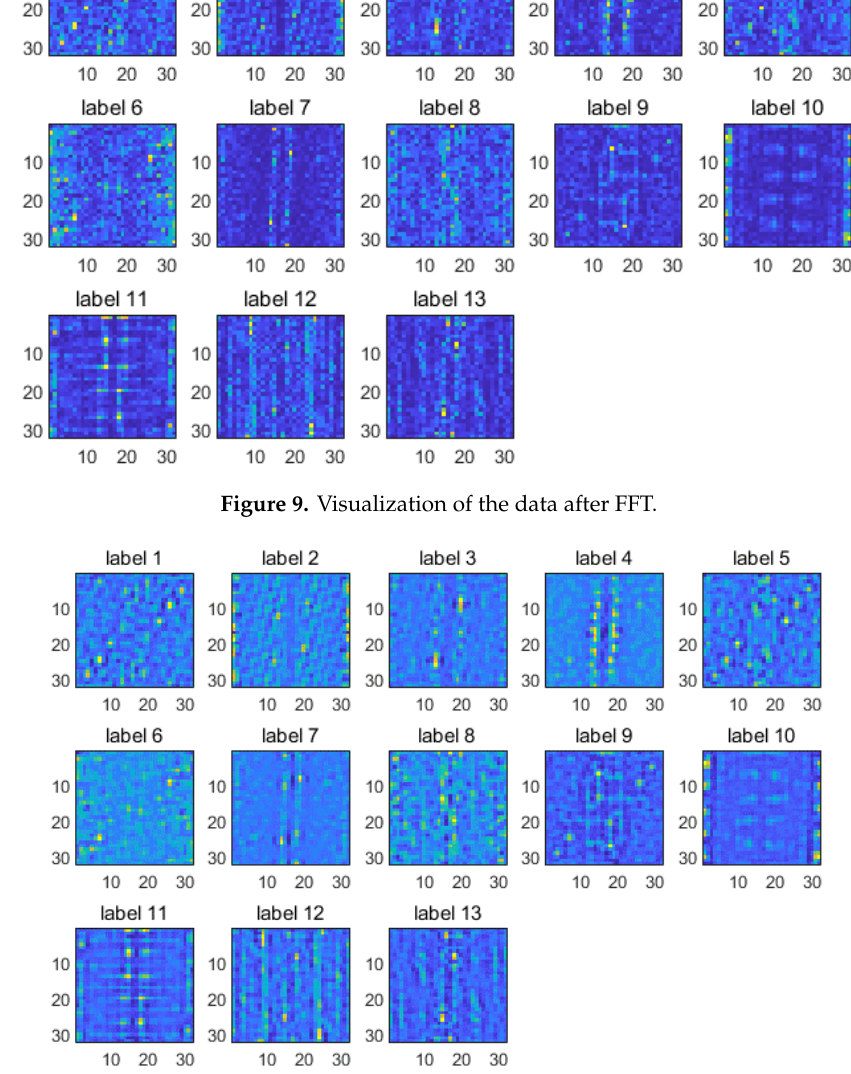
Figure 10. Visualization of data after filtering and normalization. The main purpose of this step is to filter out noise.